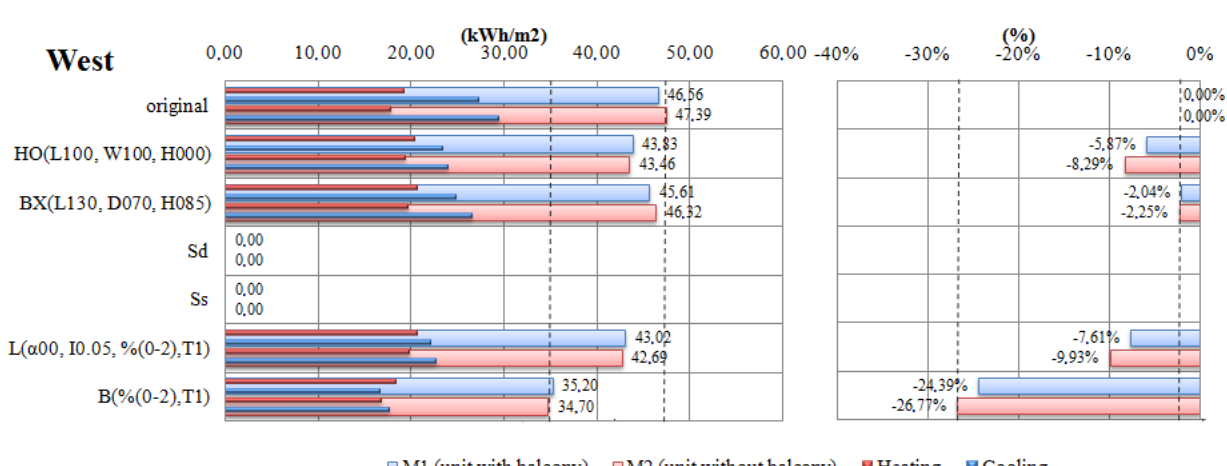
Figure 11. Annual thermal demand